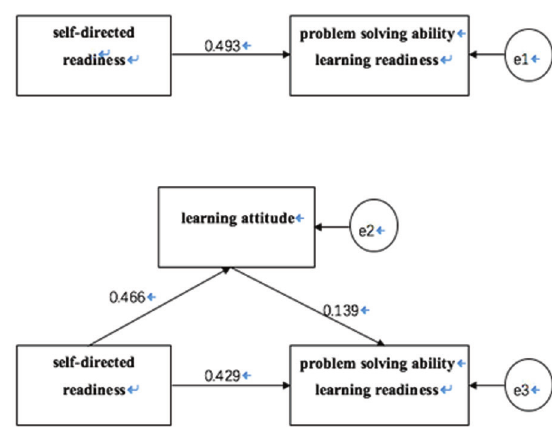
Figure 1. The mediating role of learning attitude in self-directed learning readiness and problem-solving